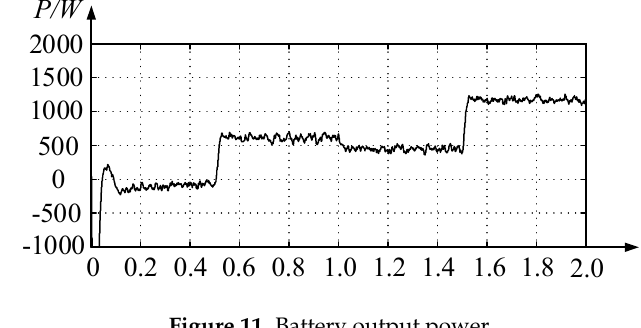
Figure 11. Battery output power.